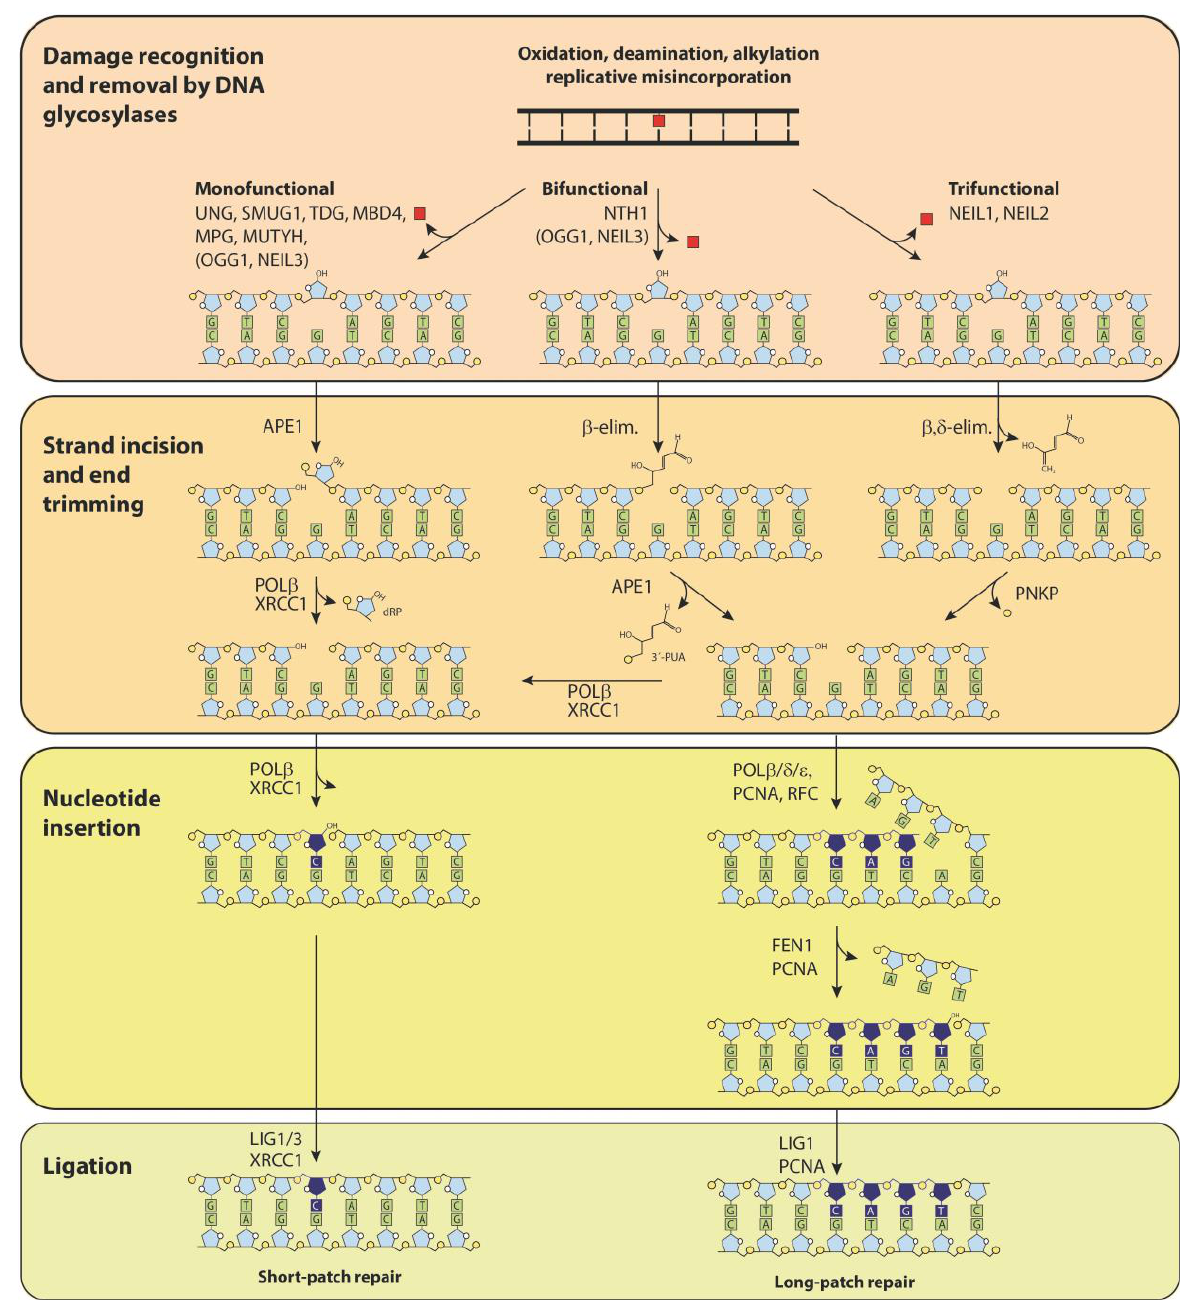
Figure 2. Subpathways in base excision repair (BER). BER takes place by either short patch repair, in which only one nucleotide is inserted (track on the left) or long patch repair, where several nucleotides are inserted (tracks on the right). The principal steps in BER include the following: 1. Damage recognition and base removal by a DNA glycosylase; 2. Strand incision and end trimming; 3. Nucleotide insertion; 4. Ligation of DNA ends. Monofunctional DNA glycosylases remove the damaged base, leaving an abasic site that is cleaved by AP-endonuclease APE1. DNA polymerase β removes deoxyribose phosphate (dRP) and inserts a single nucleotide. Bifunctional DNA glycosylases remove the base and cleave the DNA strand by β -elimination, then APE1 releases the 3 (cid:48) -PUA (3 (cid:48) -phospho unsaturated aldehyde). Trifunctional DNA glycosylases in addition remove the unsaturated aldehyde by δ -elimination, leaving 3 (cid:48) and 5 (cid:48) phosphate ends. PNKP (polynucleotide kinase/phosphatase) removes the 3 (cid:48) -phosphate. Note that short patch repair largely uses specialized enzymes in the downstream steps, whereas long patch repair involves several DNA replication proteins. Furthermore, BER of genomic uracil may take place both by short patch and long patch BER